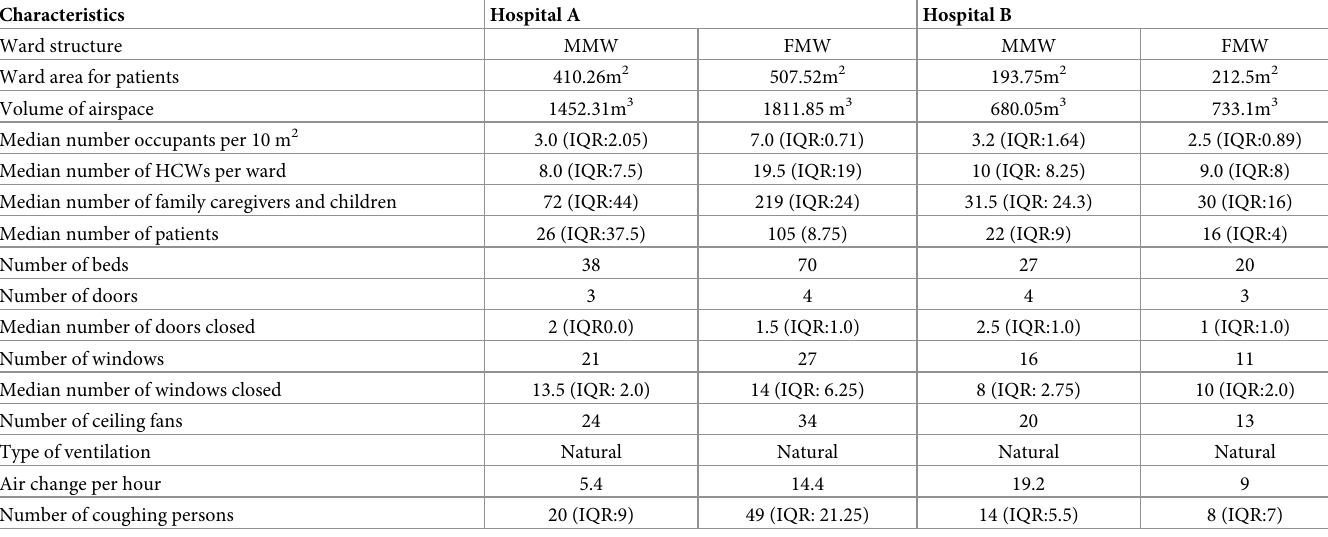
Table 1. Characteristics, ward occupancy and ventilation of four wards in two public tertiary care hospitals, 2019. Characteristics